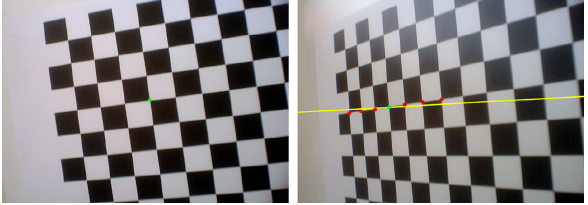
Figure 1. Node on the left image, corresponding epipolar line on the right image and the six nodes closest to the line. The green point is among them the closest and defines the correct match.